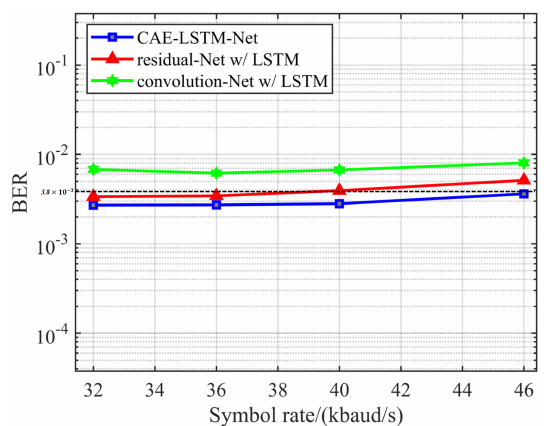
Figure 15. BER performance by using different CNN-based